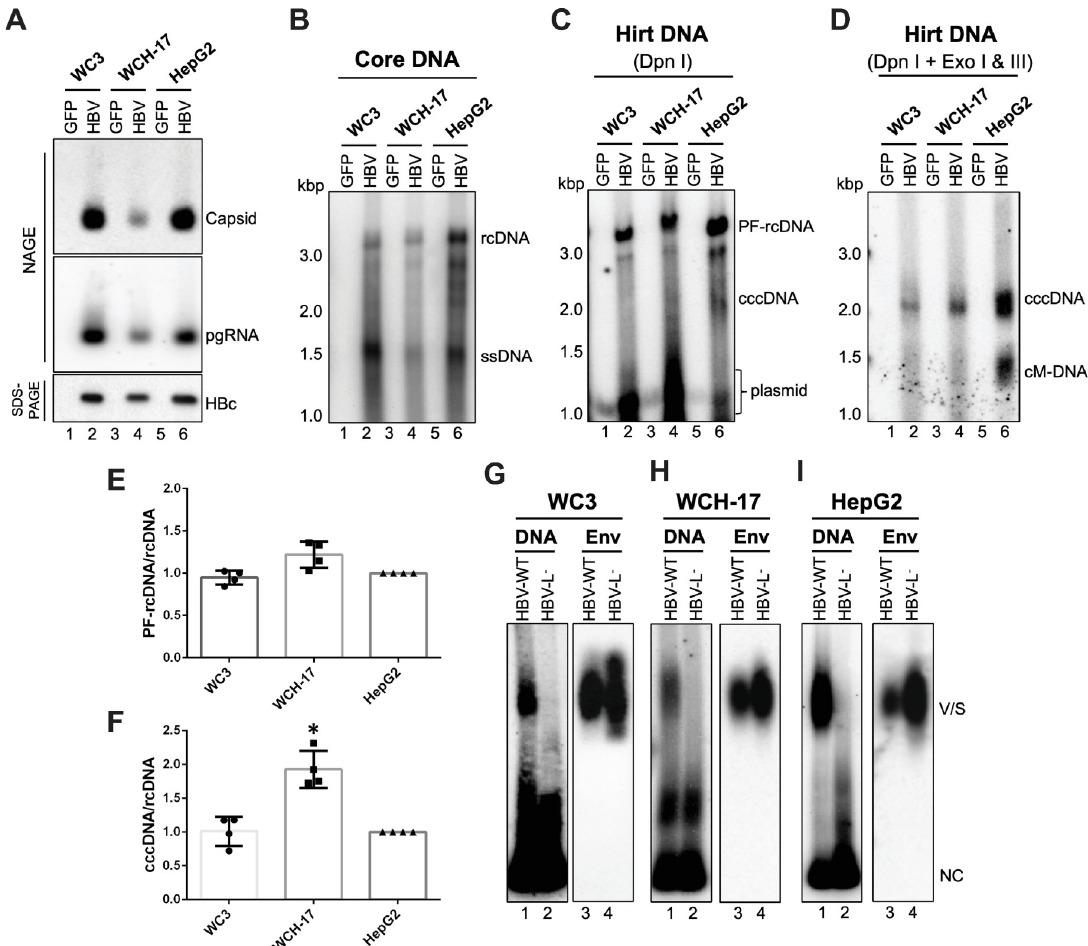
Fig 1. Woodchuck hepatic cell lines supported the HBV life cycle except entry. Woodchuck hepatic (hepatoma) cell lines WC3 and WCH-17 and human hepatoma cell line HepG2 were transfected with the HBV replicon (pCI Δ A-HBV-HBc) or control (GFP) plasmids, and cells were harvested at 5 days post-transfection. (A) Cytoplasmic lysates were resolved by native agarose gel electrophoresis (NAGE) for comparing capsid assembly (top) and pgRNA packaging (middle) or by SDS-PAGE for comparing HBc expression (bottom). (B) Viral DNA inside nucleocapsids (i.e., core DNA) were released and detected by Southern blot analysis. One twentieth of total core DNA from transfected WC3 and WCH-17 cells and one thirtieth of total core DNA from the transfected HepG2 cells was loaded. PF DNA (i.e., Hirt DNA) was extracted from transfected cells by Hirt extraction method followed by Dpn I treatment to digest input plasmid (C) or with Dpn I and exonuclease I/III (Exo I/III) treatment to remove all DNA except closed circular DNA (D) before agarose gel electrophoresis and Southern blot analysis. One seventh of total WC3 Hirt DNA, one fourth of total WCH-17 Hirt DNA, and one tenth of total HepG2 Hirt DNA extracted from transfected cells was loaded. (E, F) PF-rcDNA and cccDNA signals from each cell line were normalized to the core rcDNA to compare the efficiencies on PF-rcDNA and cccDNA formation (means ± SD, n = 4). Statistical analysis was performed using student’s t test. � , p < 0.05. (G)-(I) Concentrated culture supernatant from transfected WC3 (G), WCH-17 (H), and HepG2 (I) cells were analyzed for virion and HBsAg subviral particle secretion by NAGE and detected by HBV DNA probe, followed by immunoblotting using an anti-HBs polyclonal antibody. ssDNA, single-strand DNA; cM-DNA, closed minus strand circular DNA; Env, envelope protein; V/S, virions and HBsAg subviral particles; NC,